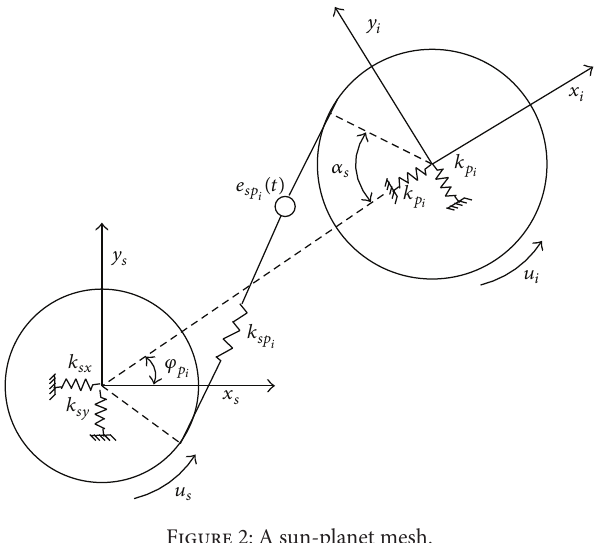
Figure 2: A sun-planet